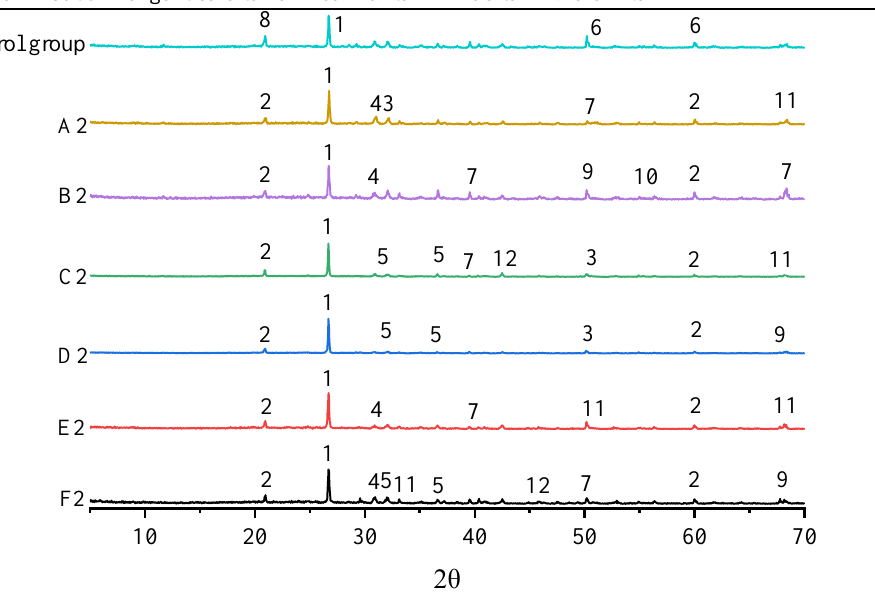
Figure 7. XRD results of samples with 0 – 6 rounds of grouting.